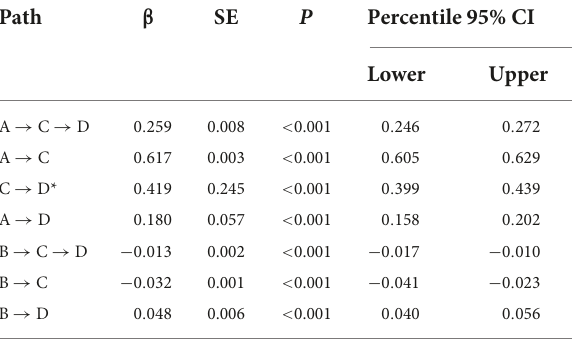
positively associated with HHB (Boscart et al., 2012;